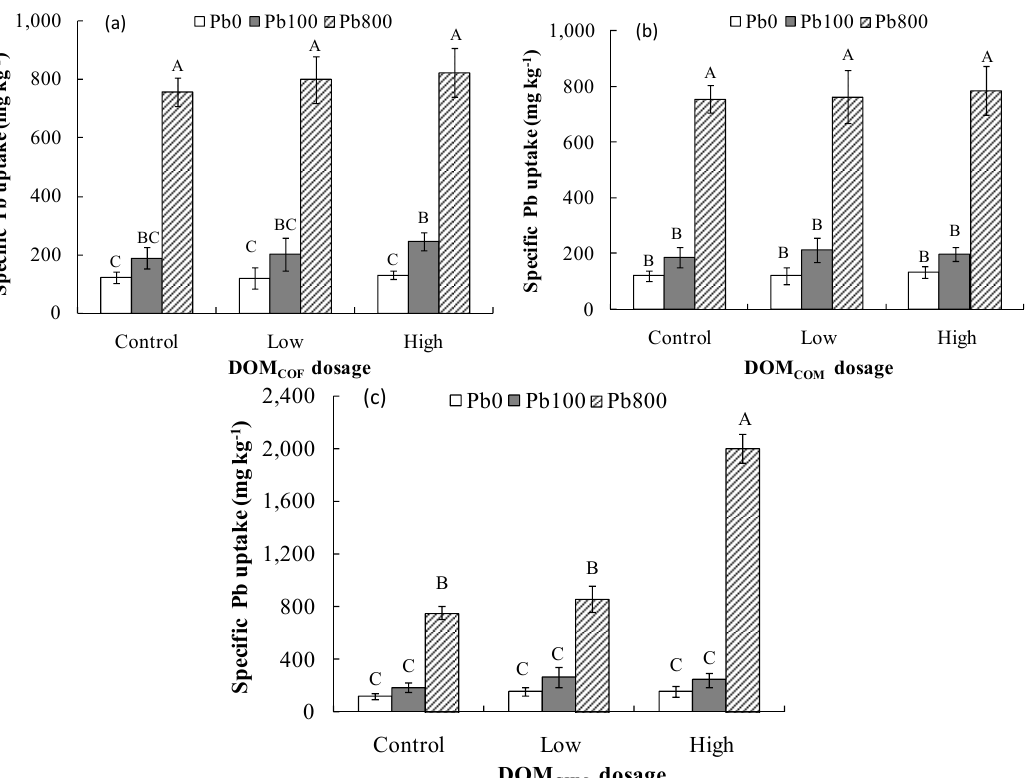
Table 5. Estimated increase in the amount of Pb ingested through vegetable consumption due to the increased concentration in the edible parts of Brassica chinensis resulting from the addition of DOM to the soil.